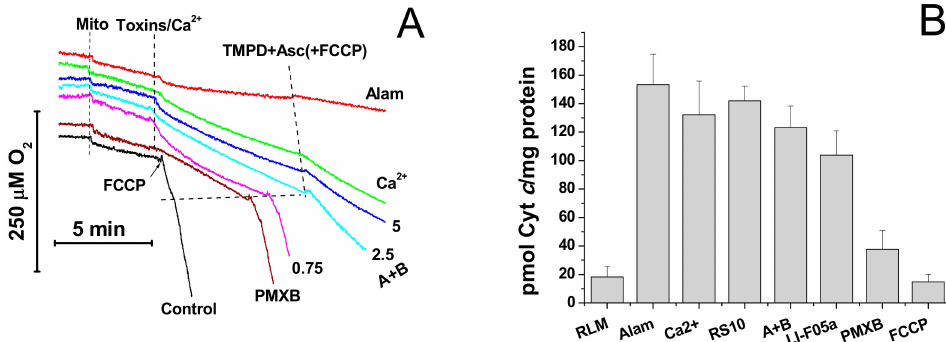
Figure 6. E ff ects of the pore formers alamethicin, fusaricidins, and polymyxin B and the mPTP inductor Ca 2 + on mitochondrial respiration ( A ) and the release of cytochrome c ( B ). ( A ) Mitochondria (Mito) (1.5 mg prot. / mL) were added to the medium with the same composition as in Figure 5A. Where shown, toxins (alamethicin (Alam, 10 µ g / mL), fusaricidins A + B (0.75, 2.5, and 5 µ g / mL), polymyxin B (PMXB, 100 µ g / mL)), 200 µ M Ca 2 + , 200 µ M TMPD (N,N,N’N’-tetramethyl-p-phenylenediamide), 2 mM ascorbate (Asc), and 500 nM FCCP were added to the suspension. The figure shows the original traces of one standard experiment of three identical. ( B ) Mitochondria (2 mg prot. / mL) were incubated in the presence of RS10 (30 µ g / mg prot.), fusaricidins A + B (8.4 µ g / mg prot.), LI-F05a (4.5 µ g / mg prot.), alamethicin (12.5 µ g / mg) (Alam), polymyxin B (100 µ g / mg protein) (PMXB), 500 nM FCCP, and Ca 2 + (250 nmol / mg of protein). The release of cytochrome c (Cyt c ) was measured as described in the Materials and Methods Section. The data presented are the means ± S.E.M. for three independent experiments. The experiments were performed at 23 ◦